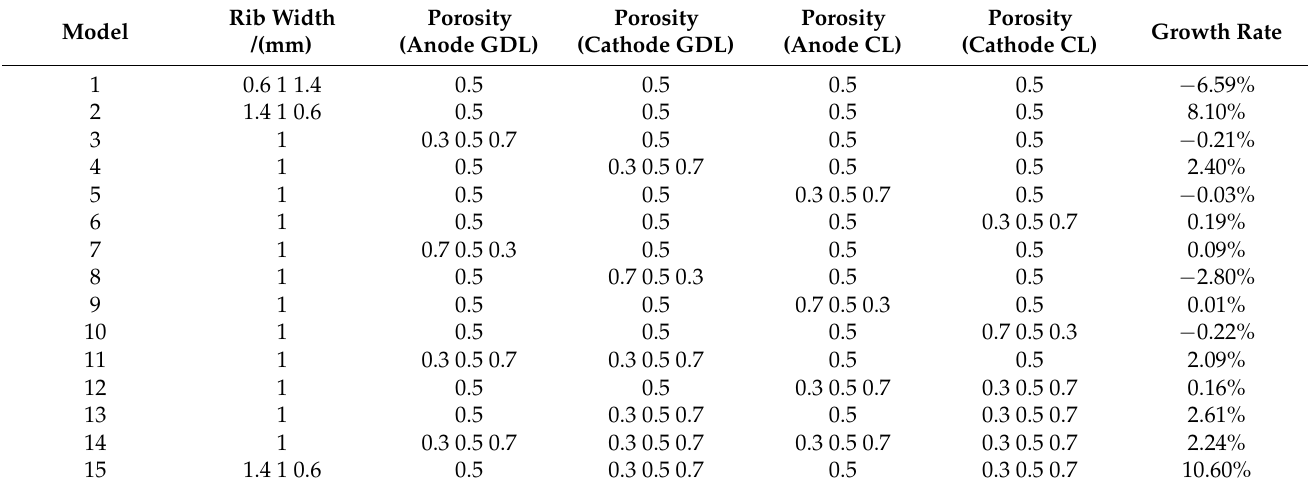
Table 4. Simulation results for uneven designs.